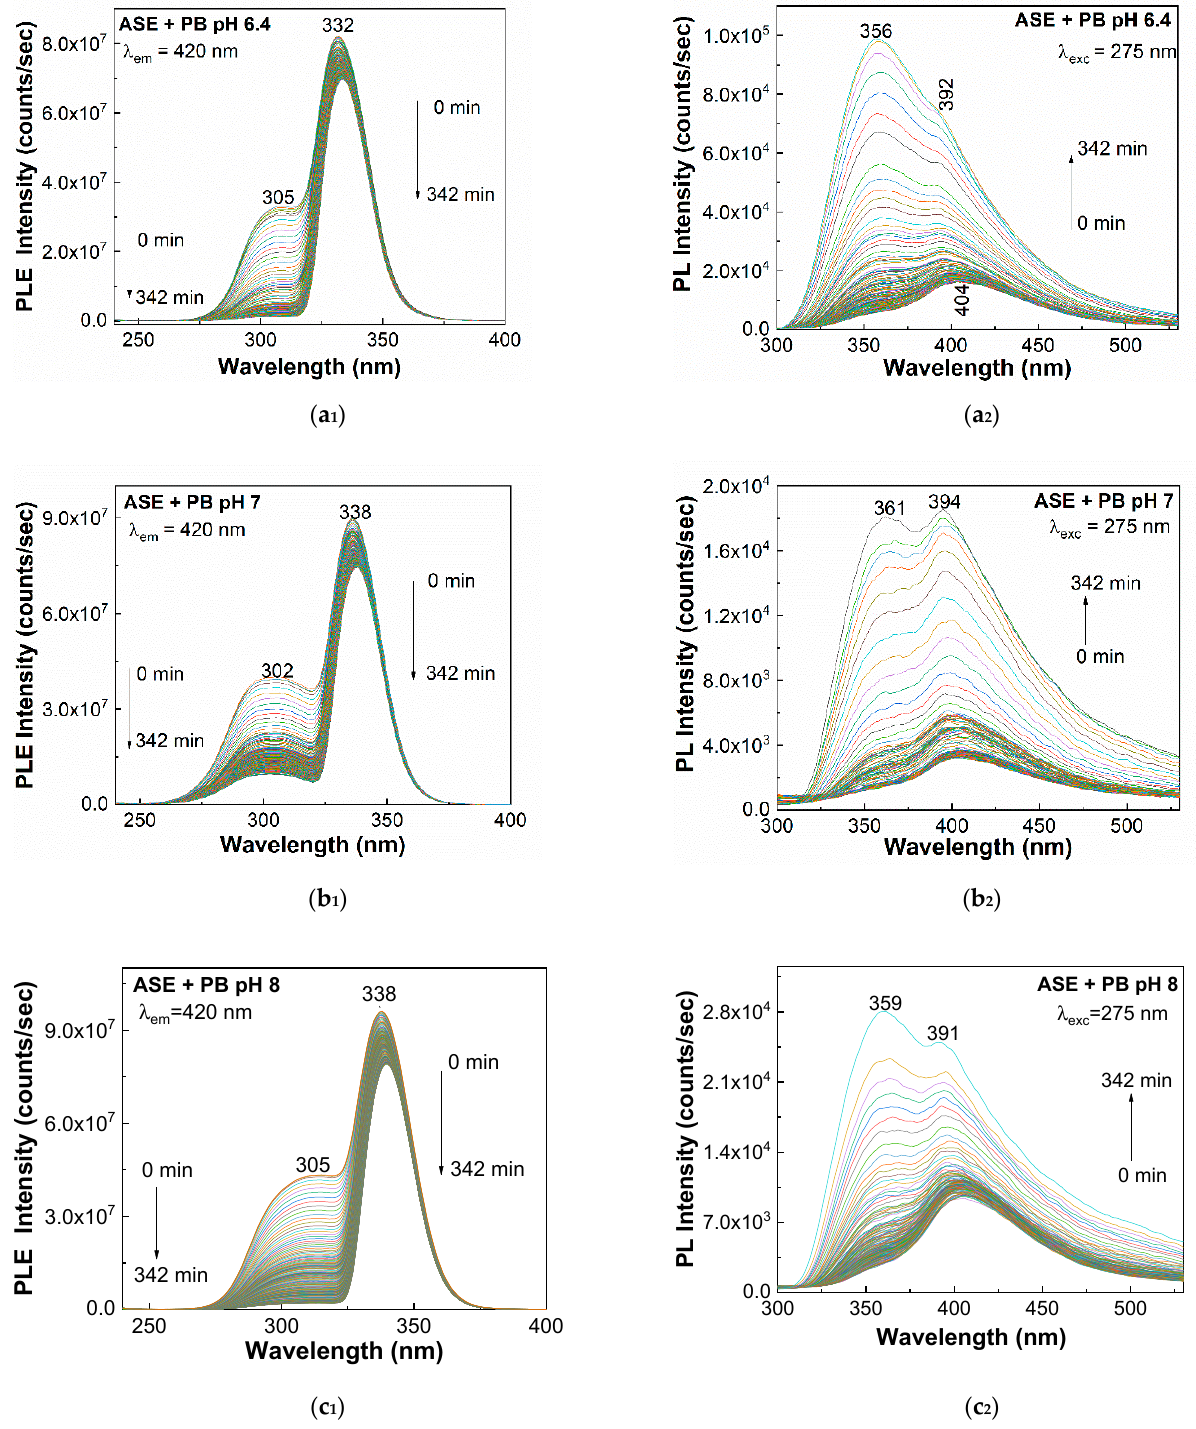
Figure 4. PLE (1) and PL (2) spectra of ASE in the presence of PB with pH equal to 6.4 ( a 1 , a 2 ), 7 ( b 1 , b 2 ) and 8 ( c 1 , c 2 ). PLE and PL spectra were recorded at the emission wavelength equal to 420 nm and the excitation wavelength equal to 275 nm, respectively.